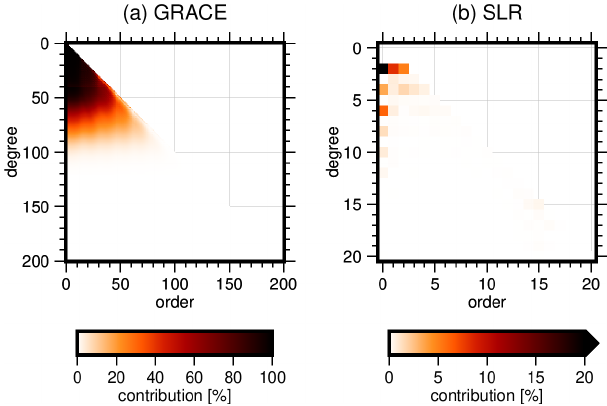
Figure 5. Contribution of (a) GRACE and (b) SLR to the estimated annual oscillation. Note the different axis